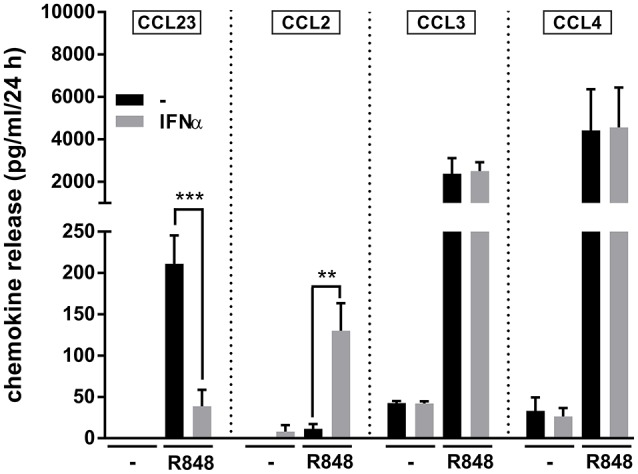
IFNα downregulates the production of CCL23 by R848-treated neutrophils Neutrophils (5 × 106/ml) were cultured with or without 1,000 U/ml IFNα and/or 5 μM R848. After 24 h, supernatants were collected and subjected to CCL23, CCL2, CCL3, and CCL4 measurement by ELISA. Data are depicted as mean ± SEM (n = 3–19). Asterisks stand for significant increases: **P < 0.01, ***P < 0.001, by two-way ANOVA followed by Bonferroni's post-test.